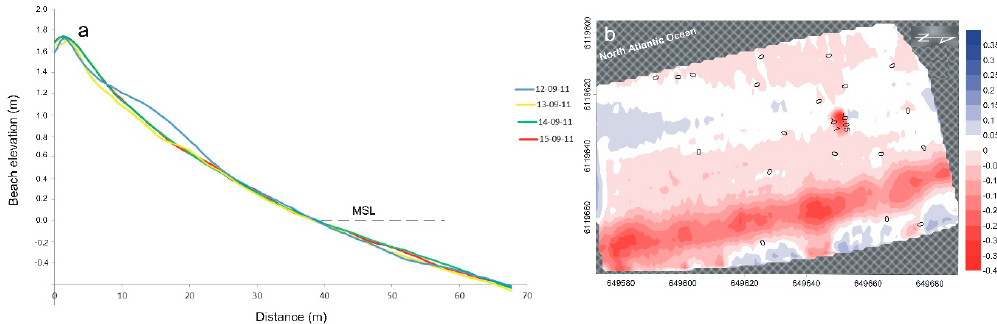
Figure 6. ( a ) Profile 2 evolution and ( b ) 3D morphological changes at Portrush Southern Sector.